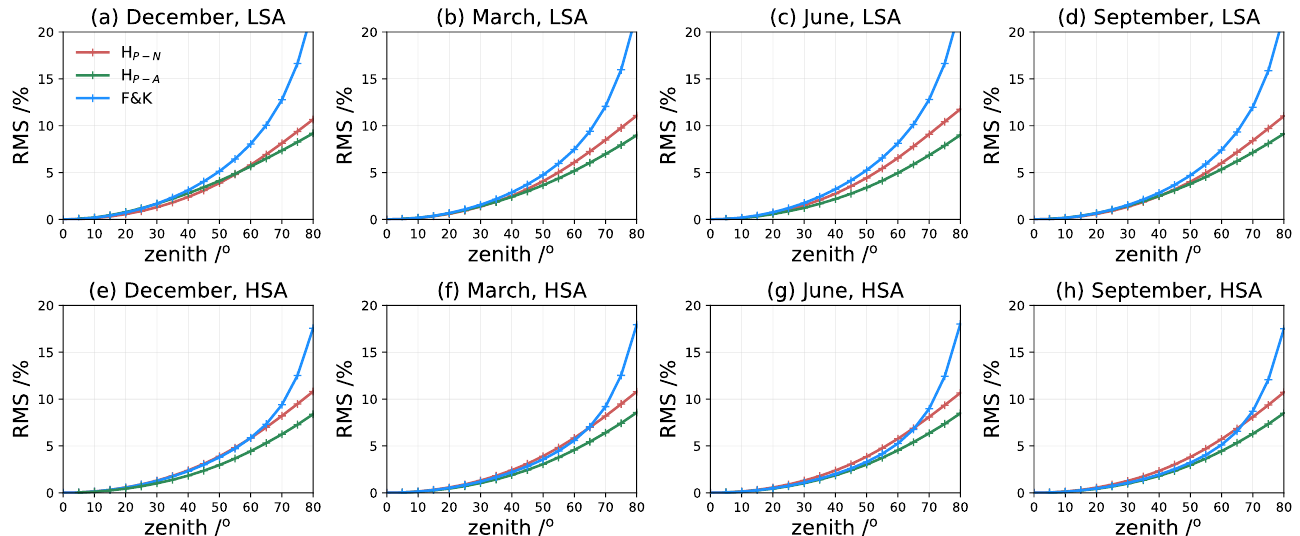
Figure 9. Same as Figure 8 but for HSA year.